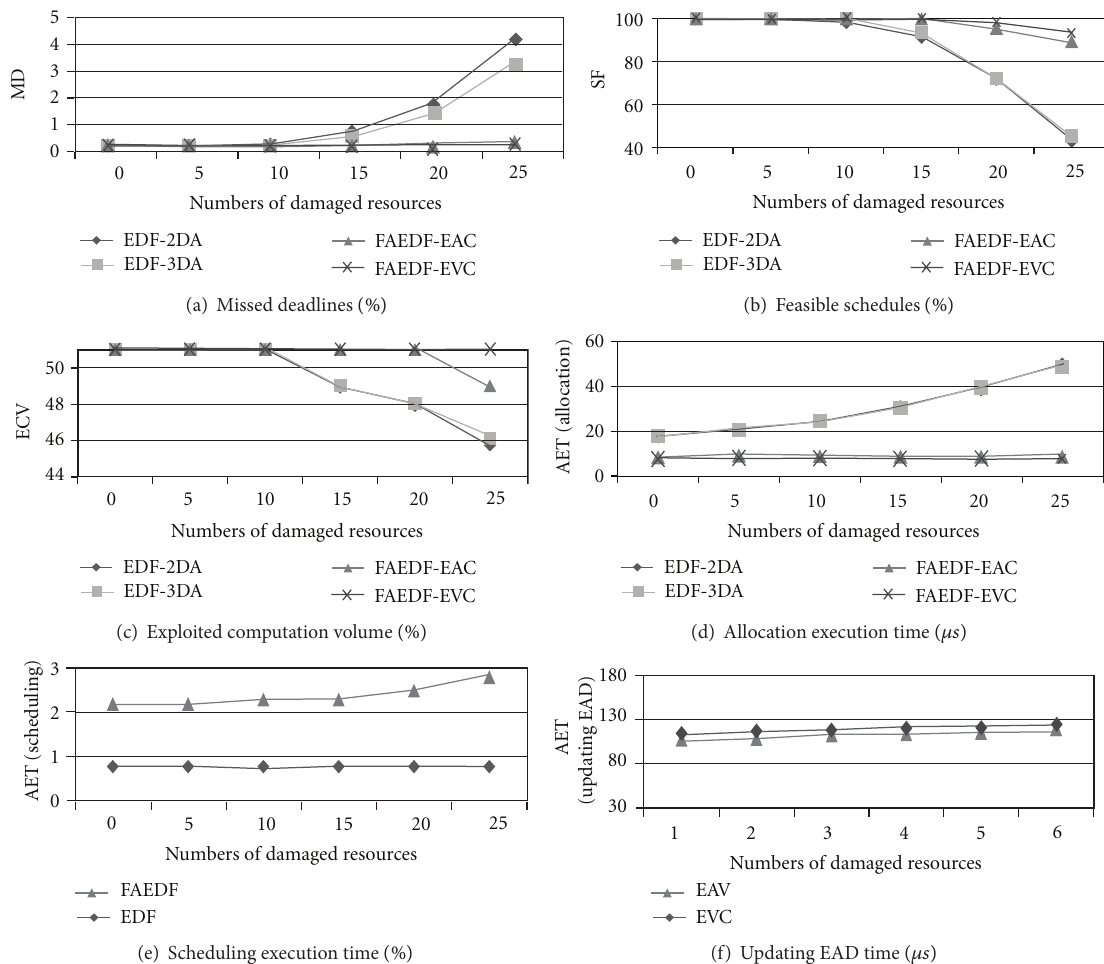
= 0.75 and 𝑈 = 0.75 . ICAP COMP